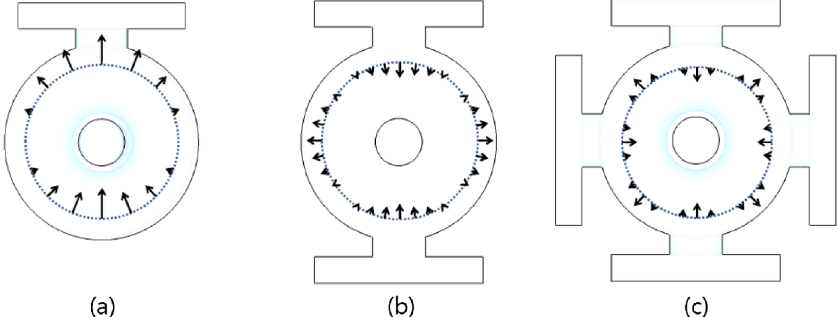
FIG. 4. Schematic drawing of each multipole mode in the rf gun. (a) Dipole mode. (b) Quadrupole mode. (c) Octopole mode.